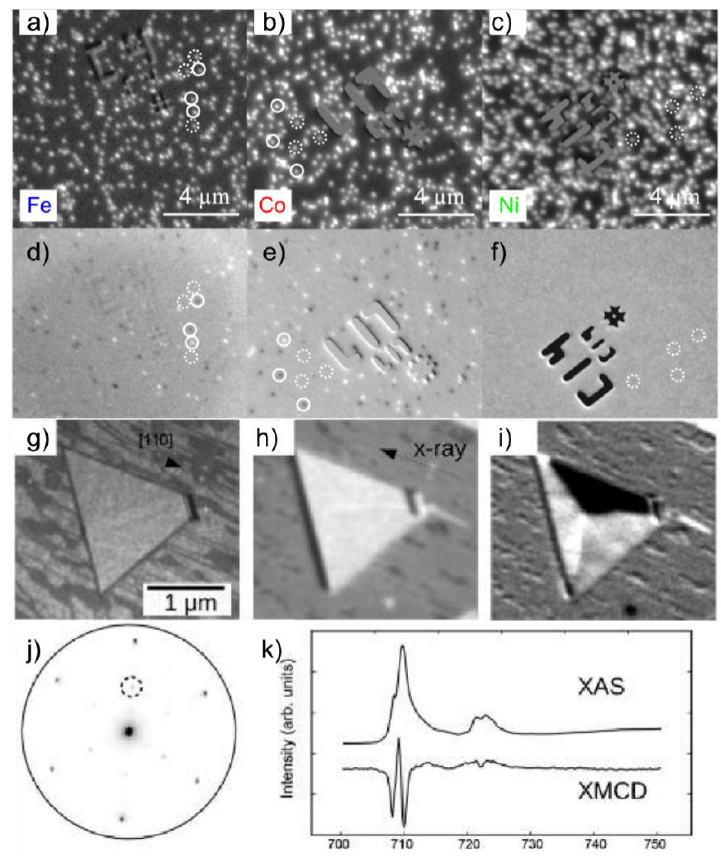
Figure 16. ( a – f ) elemental maps of the NPs: ( a ) Fe, ( b ) Co, and ( c ) Ni nanoparticles; ( d – f ) the corresponding magnetic contrast images. Dashed and solid circles represent NPs in the superparamagnetic and magnetically blocked states, respectively. Au markers shown in the images are used for the particle identification. Reproduced with permission from [178], copyright (2017) by American Physical Society. ( g – k ) multitechnique imaging of a Fe 3 O 4 (magnetite) island on an FeO wetted layer on the Ru(0001) surface: ( g ) LEEM image (electron energy = 8 eV), ( h ) XAS image of the same area acquired at a photon energy close to the maximum of the L 3 Fe absorption edge, ( i ) X-ray magnetic circular dichroism image of the same area, ( j ) low-energy ED pattern acquired from the island at 30 eV. One of the ED spot, characteristic of the spinel phase is shown by a circle. ( k ) XAS spectrum of the island showing the L 3 and the L 2 Fe edges and XMCD spectrum taken in the black domain in ( i ). Reproduced with permission from [179], published by The Royal Society of Chemistry, 2018.